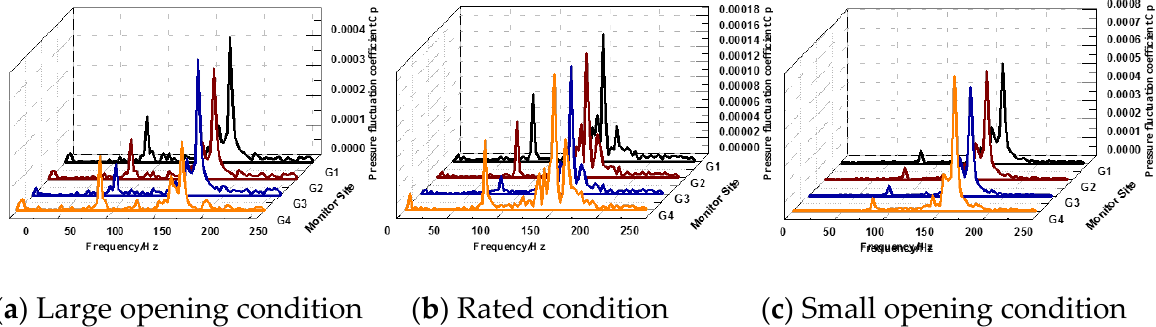
Figure 9. Volute pressure pulsation frequency domain diagram.